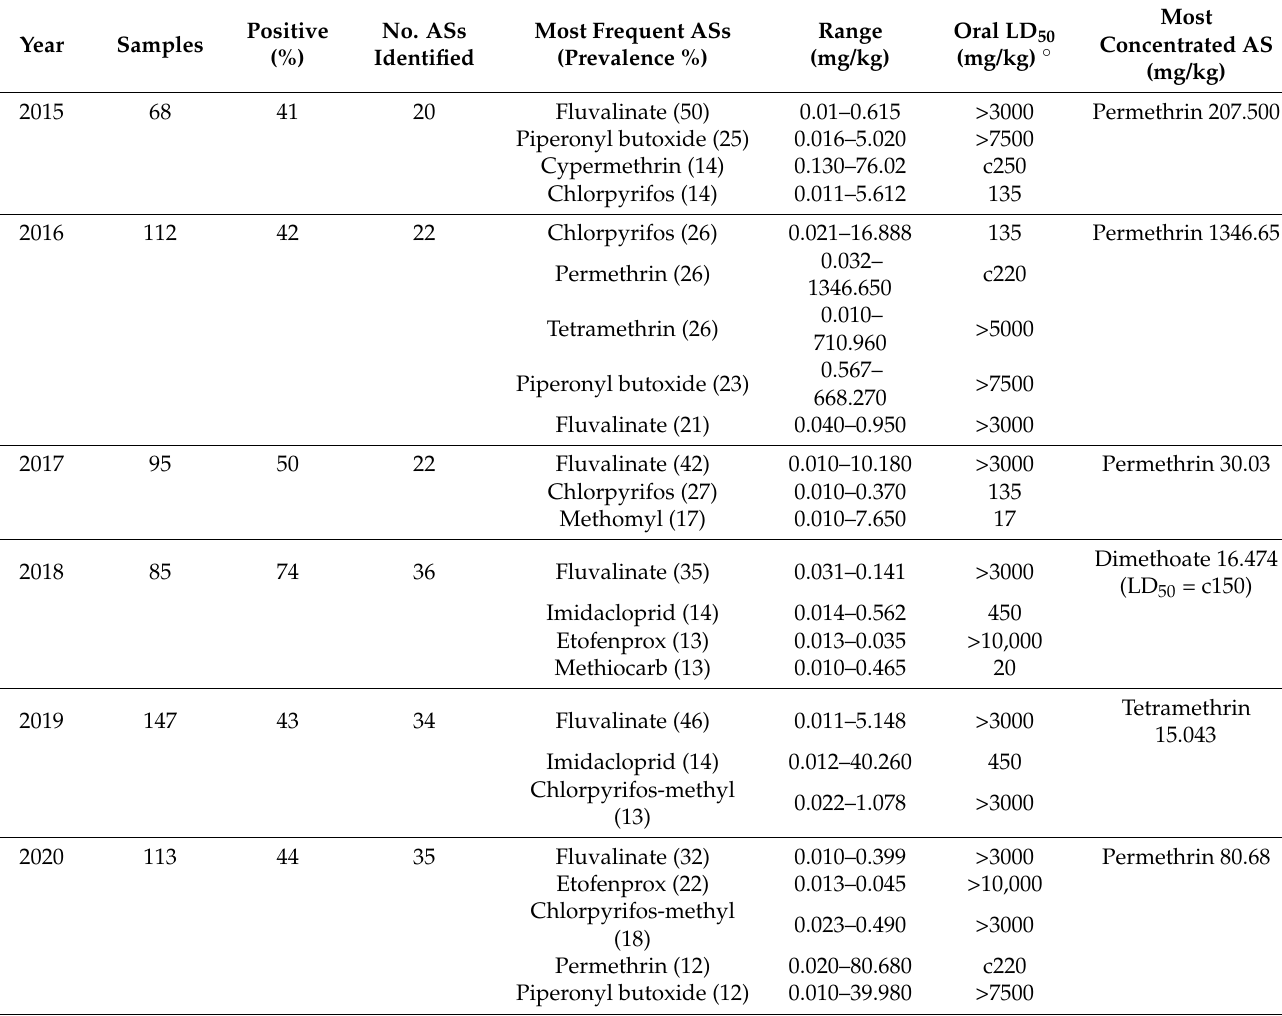
Table 1. Summary of honey bee samples collected from bee-killing incidents analyzed between 2015 and 2020.